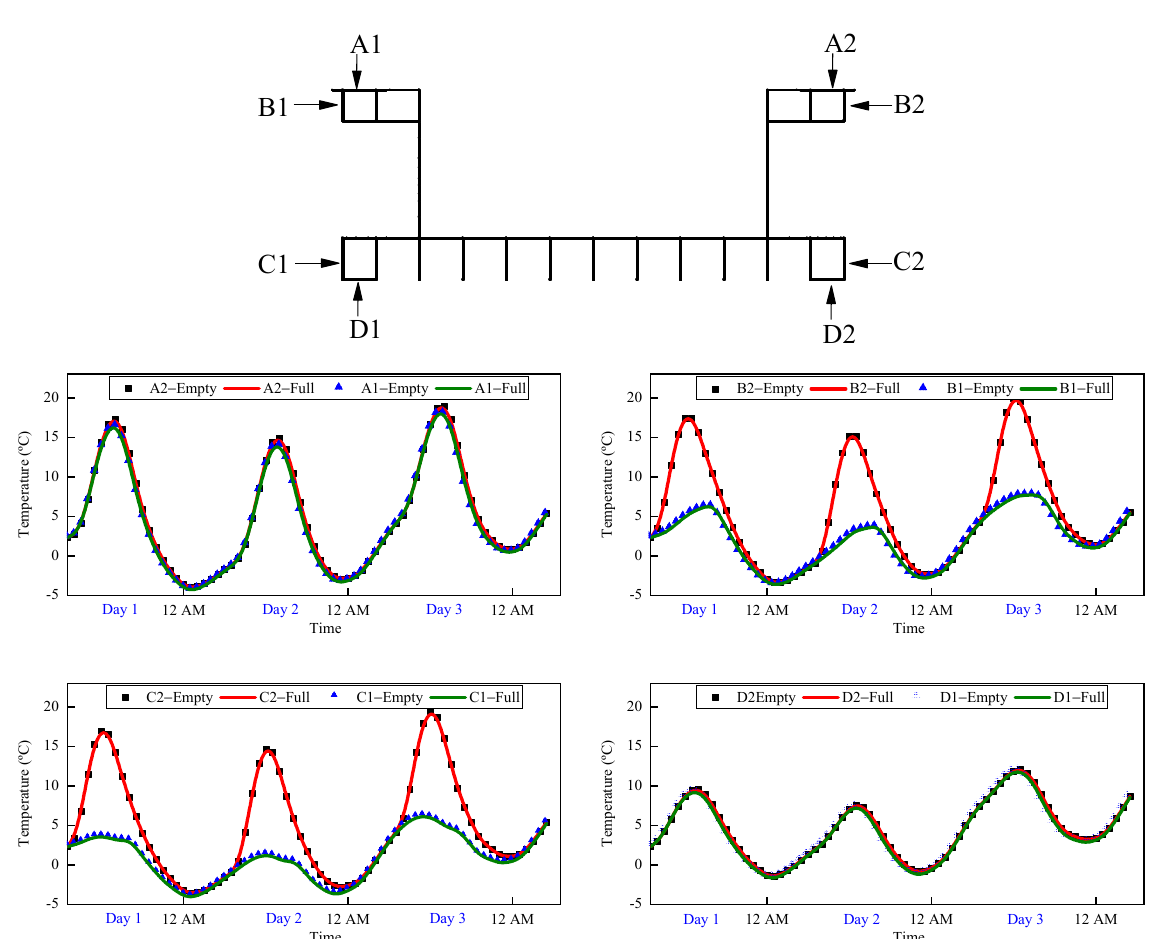
Figure 15. Simplified temperature gradient under the full-water condition in summer. Several key points on different surfaces are selected to show the temperature changes over 72 h in winter, as illustrated in Figures 16 and 17. These points have the same defini- tions as those in Figure 11.